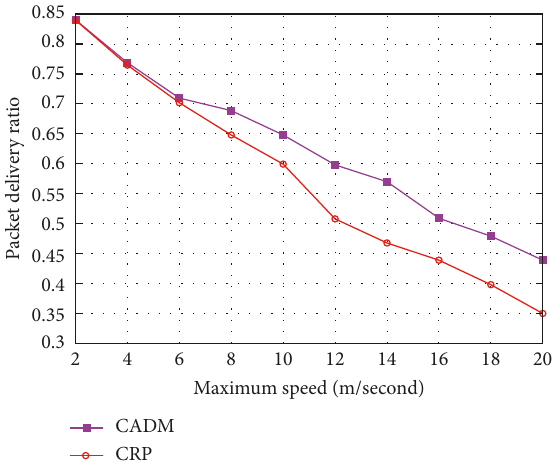
Figure 9: Average end-to-end delay with varying nodes speed.